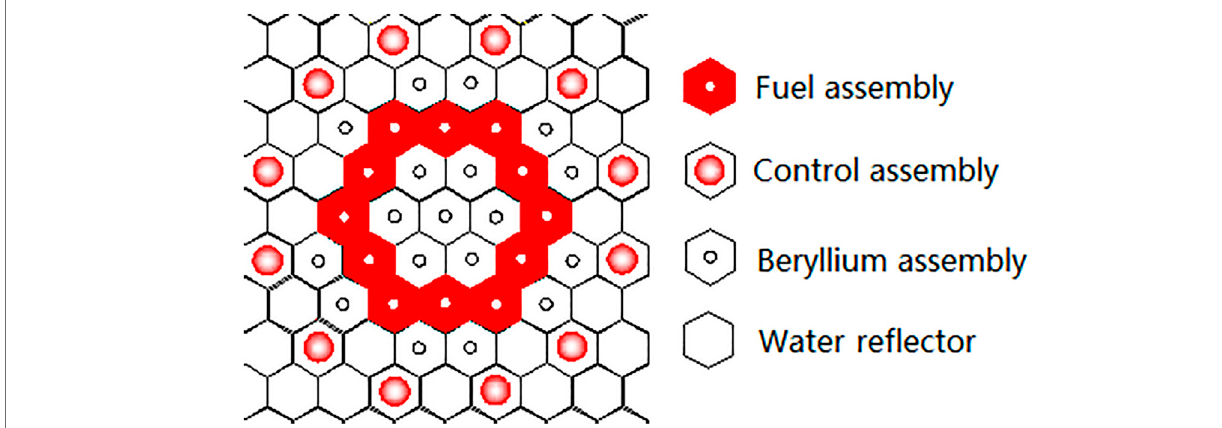
FIGURE 5 | Core arrangement of Scheme 4.